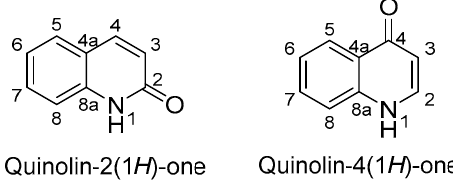
Figure 1. Structures of quinolin-2(1 H )-one and quinolin-4(1 H )-one.